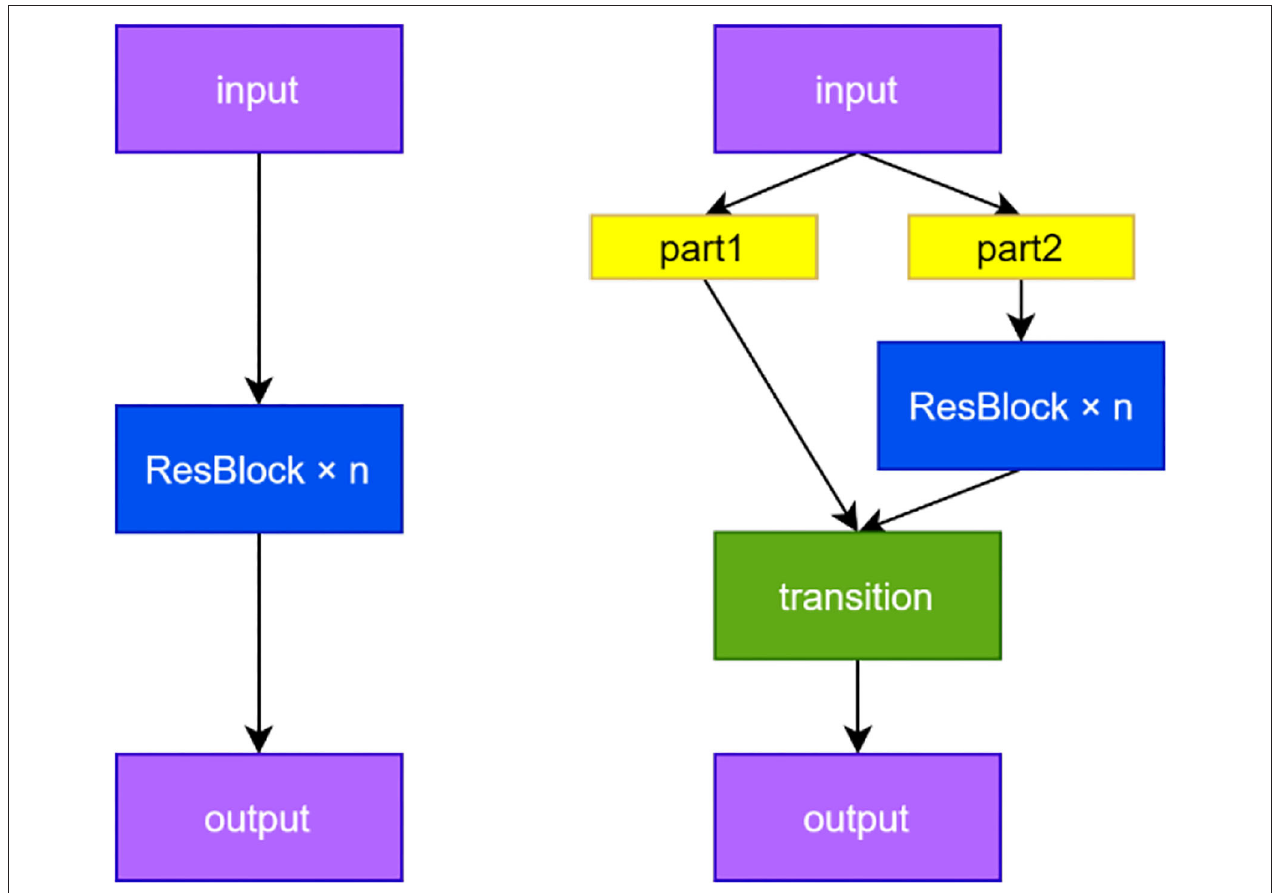
FIGURE 3 | ResNet and CSPResNet